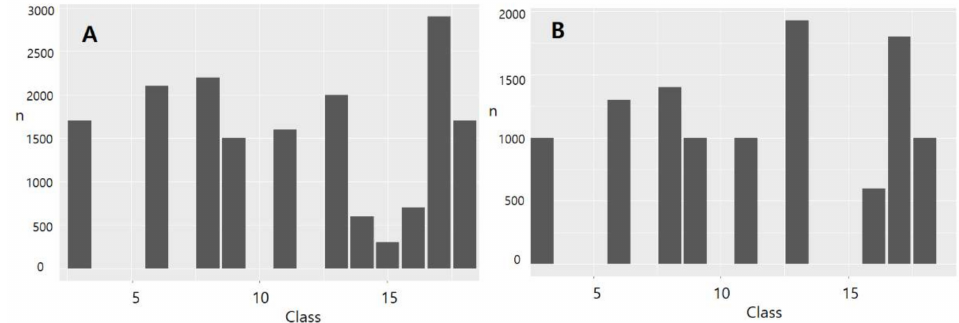
Figure 11. Pixels per class for the randomly selected training input for Approach 2 in Thohoyandou where ( A ) is unmerged and ( B ) is